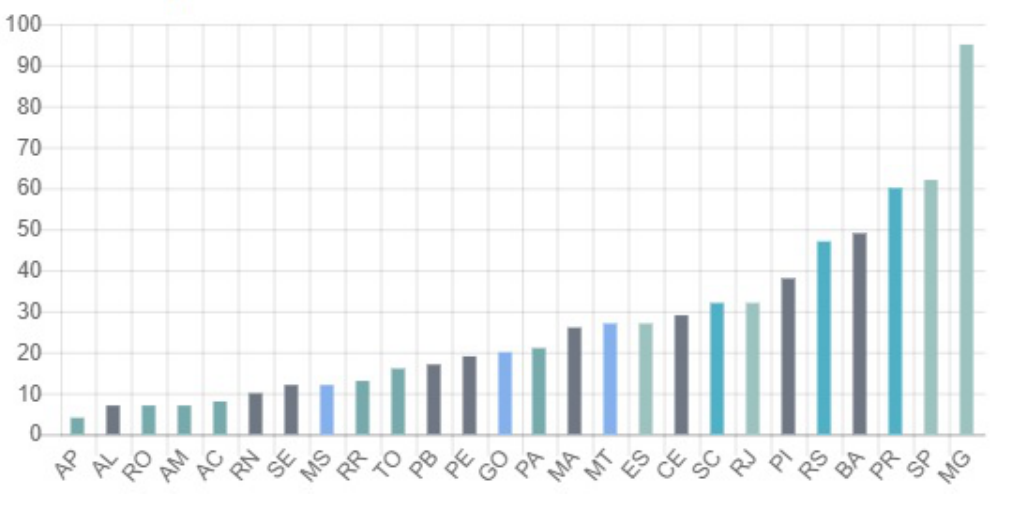
Figure 3. UAB general data: Number of learning centers per state. Retrieved from “Grupo de Pesquisa UAB,” 2019 (http://uab.educacaoaberta.org/ ). CC